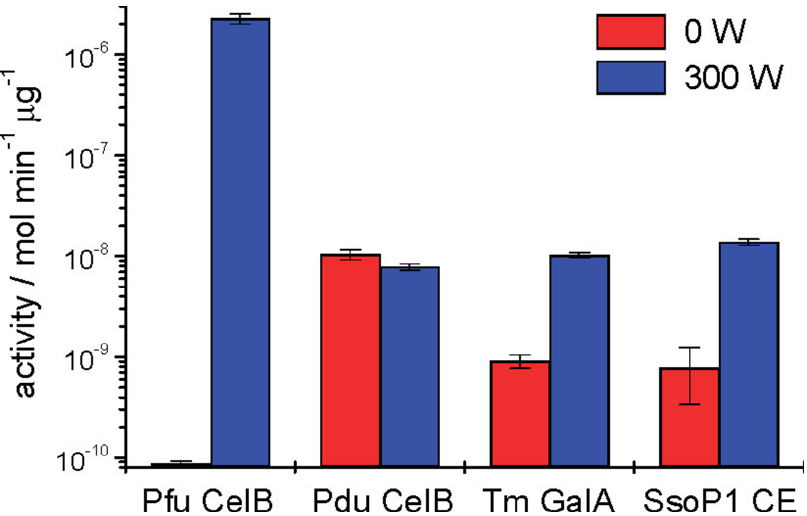
Figure 6. The Effect of microwave irradiation on different enzyme activity including Pfu CelB ( β - glucosidase from Pyrococcus furiosus ), Pdu CelB ( β -glucosidase from Prunus dulcis ), Tm GalA ( α - galactosidase from Thermotoga maritima ), and SsoP1 (carboxylesterase from Sulfolobus solfataricus P1). Reprinted with permission from Douglas et al., American Chemical Society